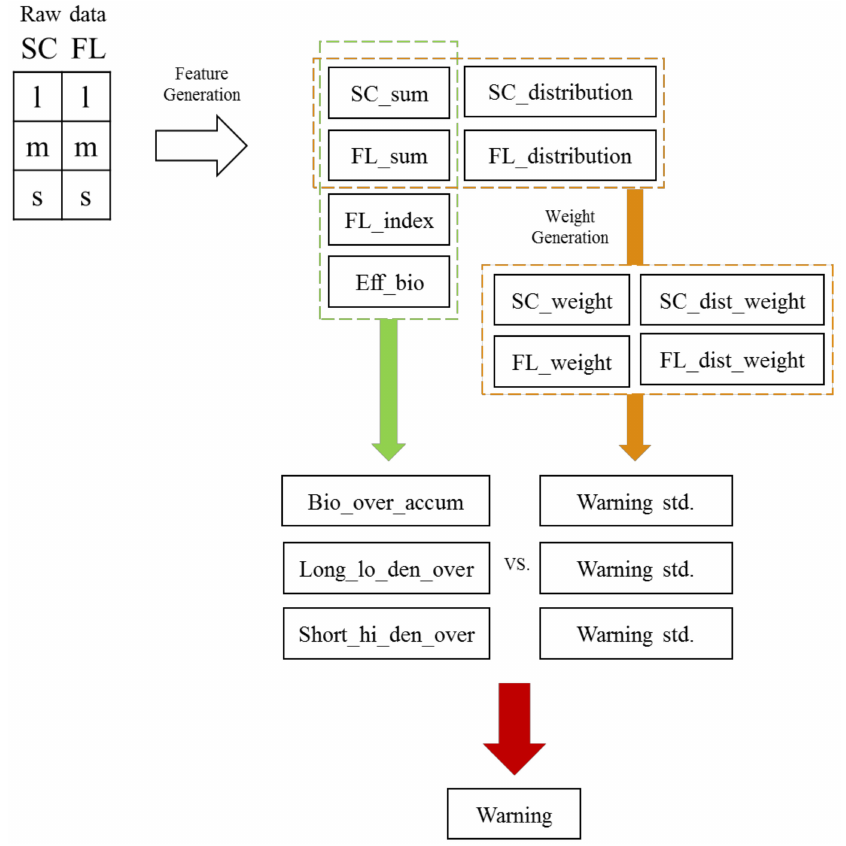
Figure 1. Parameters and design of the detection